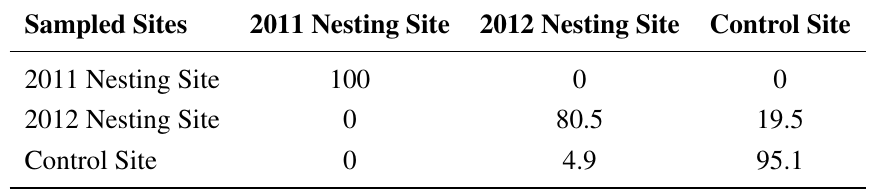
Table 5. Classification results of the discriminant model for the three sites (2011 Nest, 2012 Nest and Control Site) used by Socotra Cormorants in the